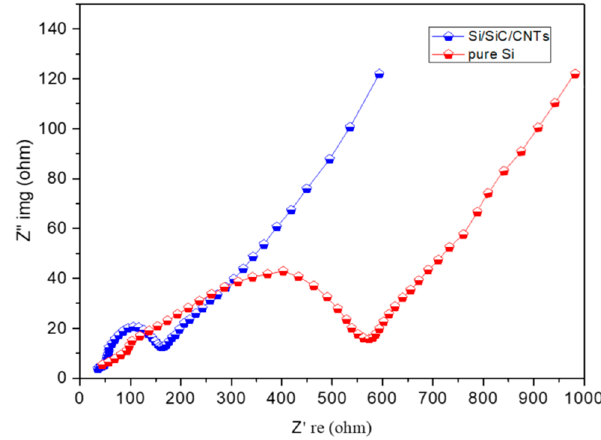
Figure 9. The EIS spectra of Si/SiC/CNT anode and pure Si anode after 100 cycles.